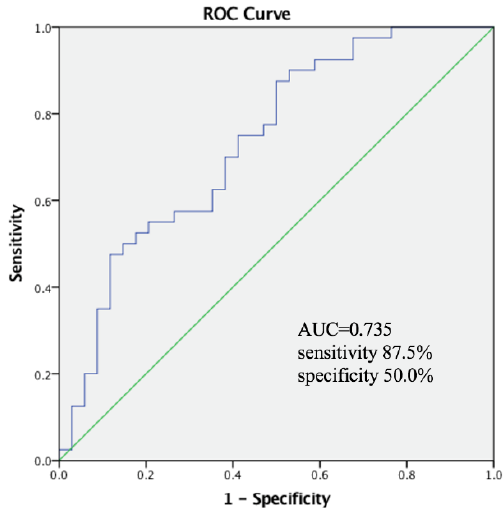
Figure 5. Receiver-operating curve analysis for phase angle (PhA) to distinguish moderate/severe malnutrition in man according to the GLIM criteria with optimal PhA level cut-off of 5.53 ◦